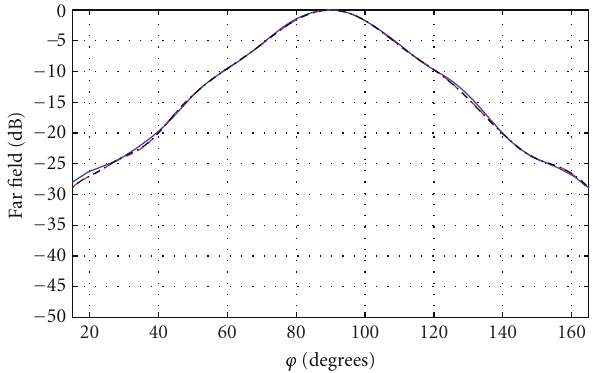
Figure 11: Dual horn, vertical polarization. ϕ cut of the ϑ compo- nent of the far field. Blue solid line: proposed approach, when no probe-compensation is applied. Red dashed line: approach in [7, 8]. Black dash-dot line: standard, probe compensated NF-FF